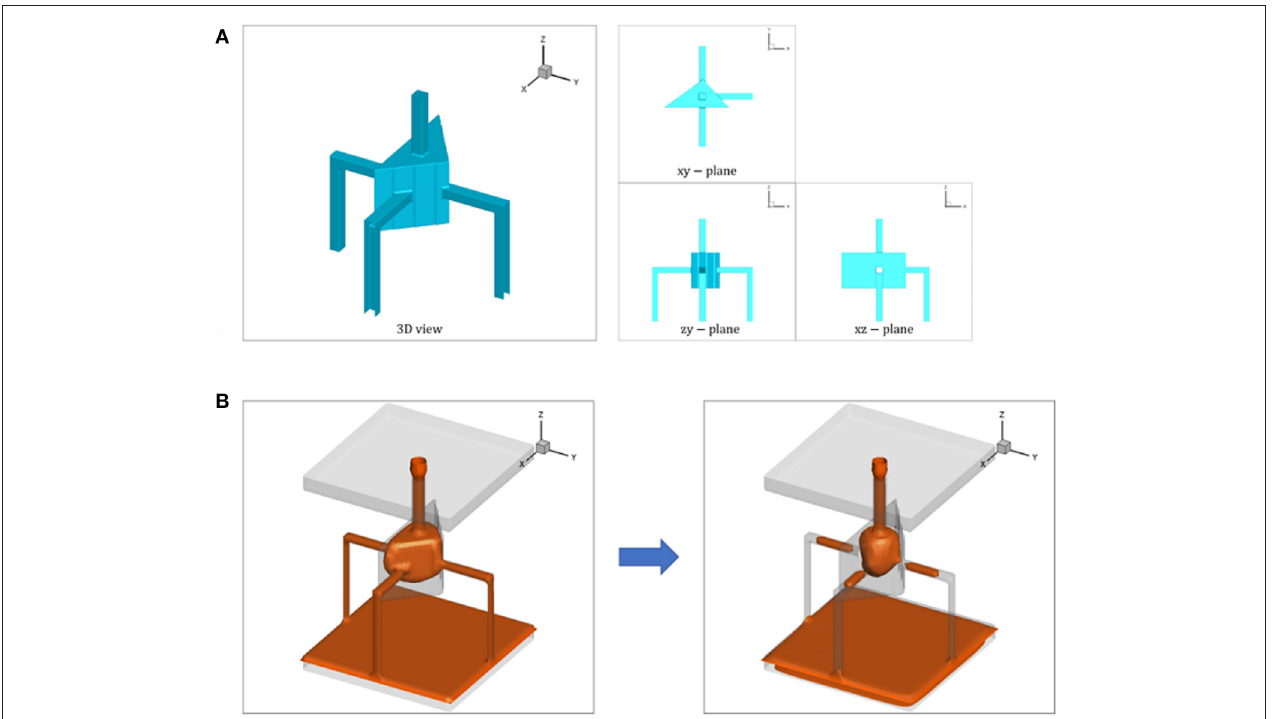
FIGURE 4 | Pore-body filling configuration for the shape factor of G = 0.040 designed for modeling I 1 event: (A) The equal length and cross section of pore-throats provide the desired simultaneous invasion. (B) LB simulation of pore-body filling during drainage (left) and imbibition (right) processes. CO 2 is shown in red and brine is transparent.